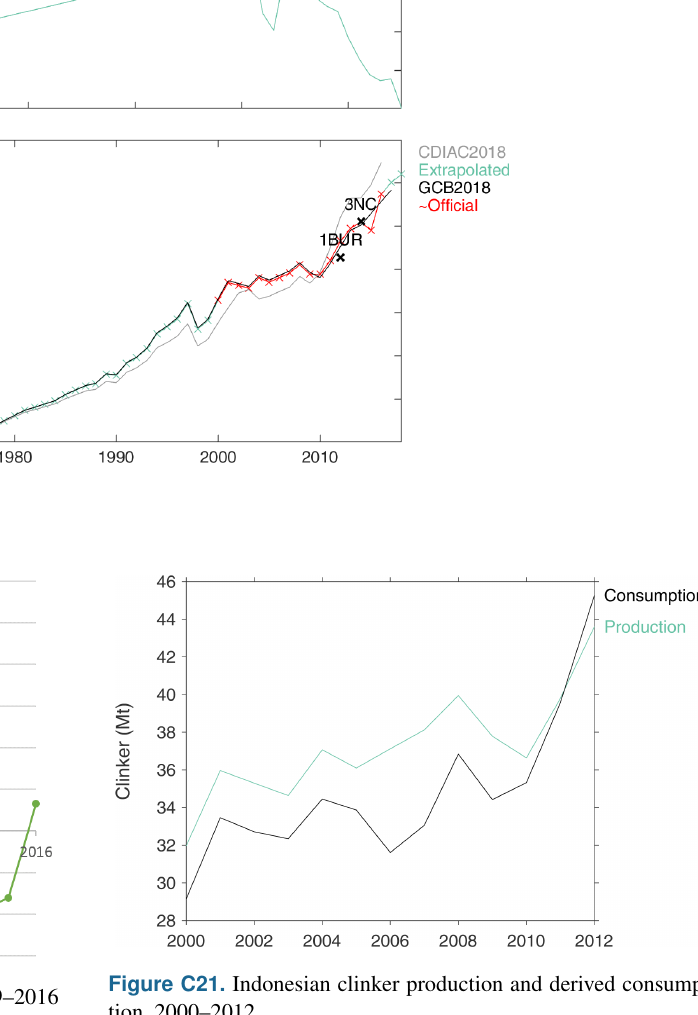
Figure C20. Net clinker exports from Indonesia, 1999–2016 (source: Statistics Indonesia).